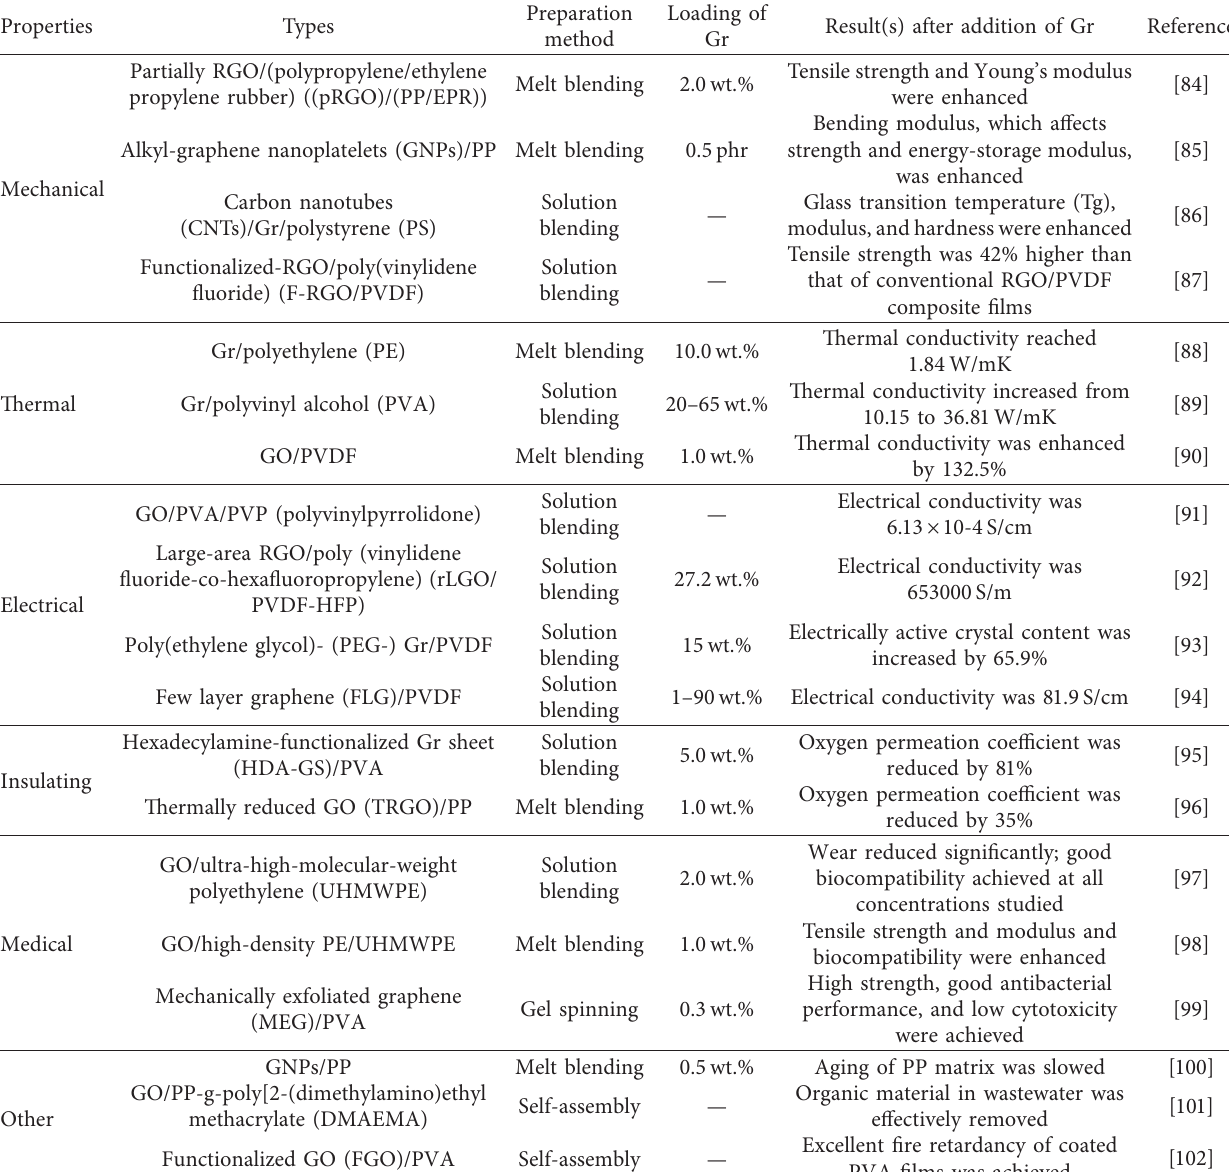
Table 6: Properties and preparation methods of composite materials comprising graphene and conventional polyolefin or its